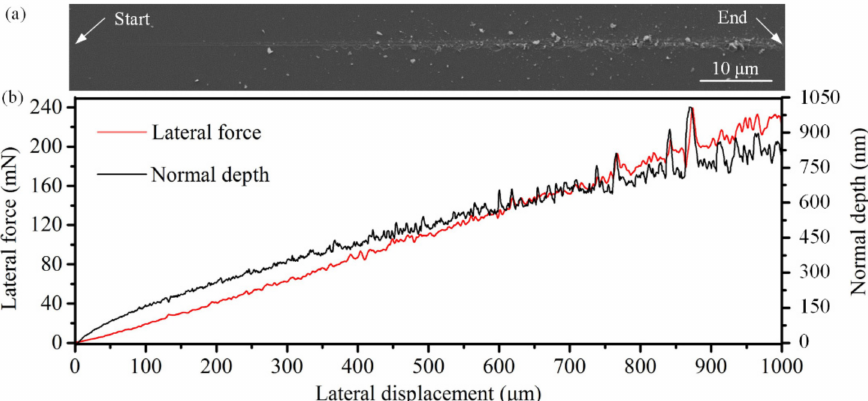
Figure 8. Experimental results of a ramp-load scratch test on 4H-SiC single crystals with a Berkovich indenter: ( a ) SEM image of the scratch track and ( b ) normal depth and lateral force as a function of lateral